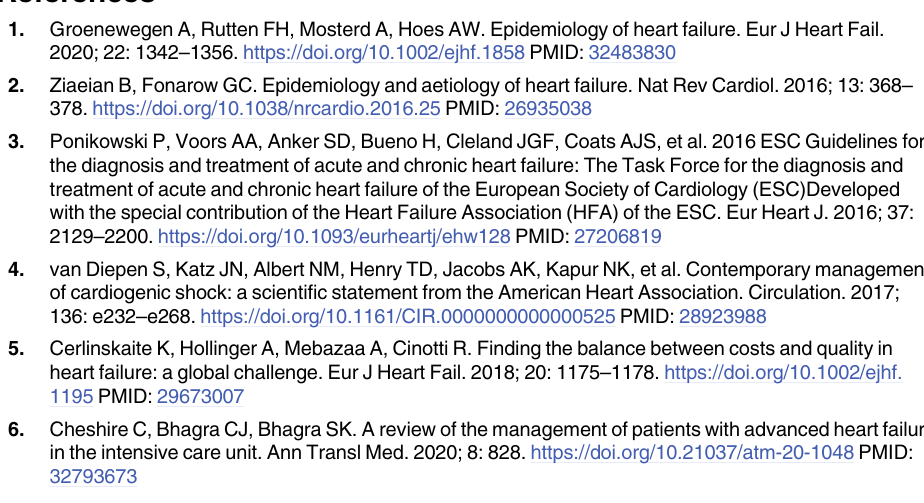
S6 Table. Multivariable analysis for interaction with ICU admission. BMI: body mass index; COPD: chronic obstructive pulmonary disease; CRD: chronic renal disease; DCM: dilated cardiomyopathy; HF: heart failure; ICU: intensive care unit; IHD: ischemic heart dis- ease; NYHA: New York Heart Association; PH: pulmonary hypertension; pre-ADL: activity of daily living at admission; PVD: peripheral vascular disease; VHD: valvular heart disease. S7 Table. Activities of daily living at discharge (post-ADL), length of stay (LOS) and admission expense (expense) in the matched cohort of patients with ADL < 60, age � 60 years, and without cerebrovascular diseases. Data are shown as mean (standard